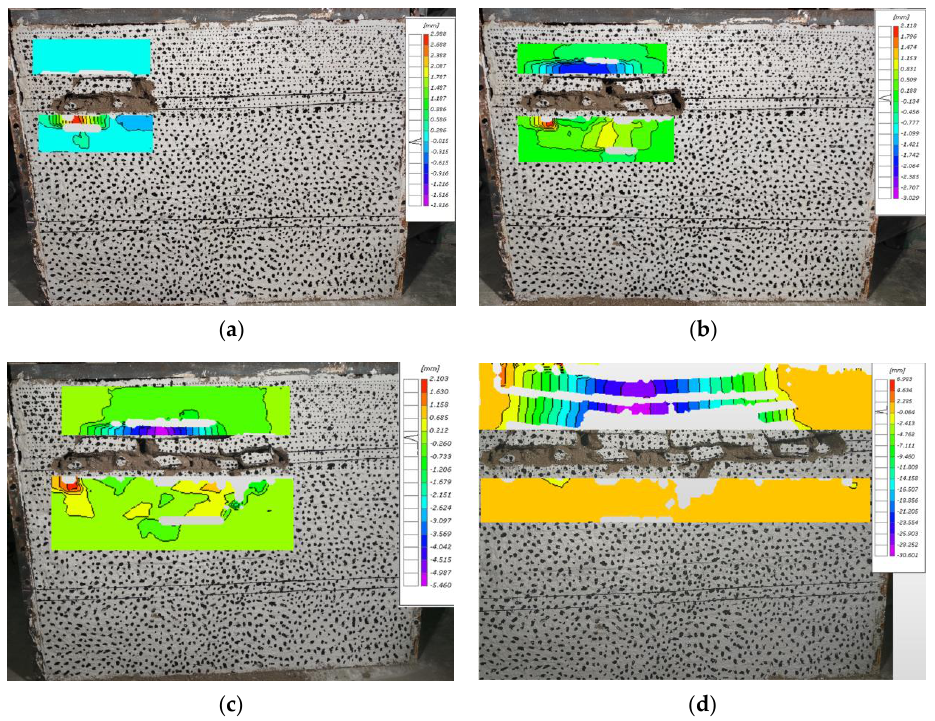
Figure 18. Displacement diagram of working face propulsion at different distances: ( a ) displacement diagram of 30 m advancement of simulated working face; ( b ) displacement diagram of 50 m ad- vancement of simulated working face; ( c ) displacement diagram of 60 m advancement of simulated working face; and ( d ) displacement diagram of 80 m advancement of simulated working face.